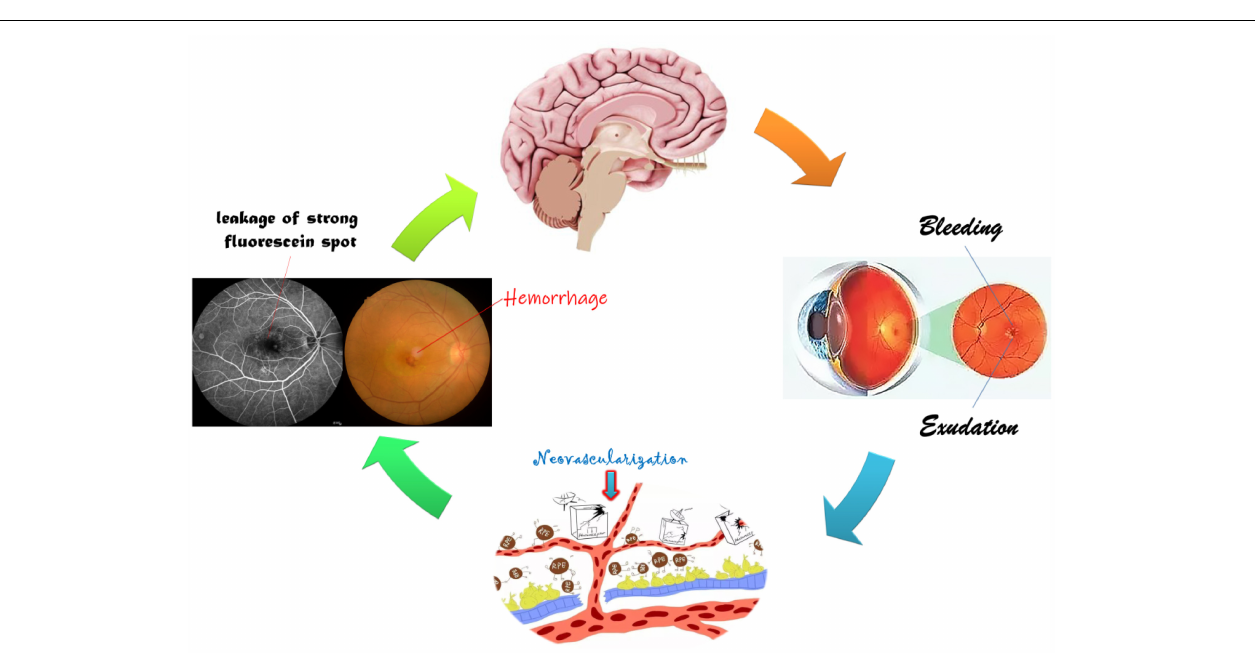
FIGURE 8 | Relationship between FC and clinical manifestation of AMD. The retinal macular is stimulated by a variety of growth factors and inflammatory factors resulting in neovascularization, hemorrhage, and exudation, further leading to visual impairment and changes in specific cerebral